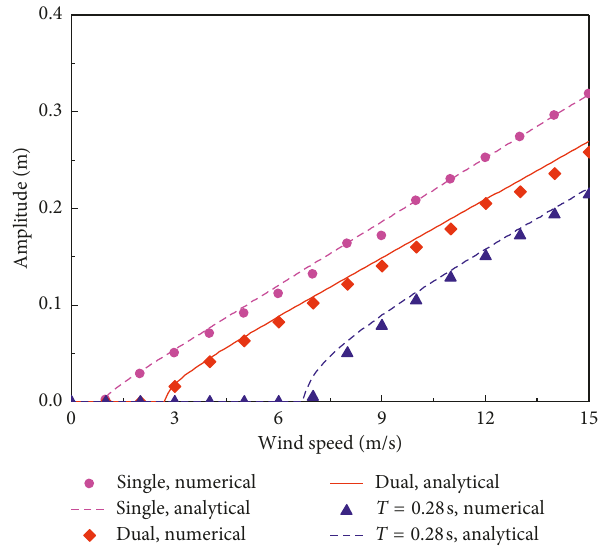
Figure 2: Variation of galloping amplitude of m for different systems.